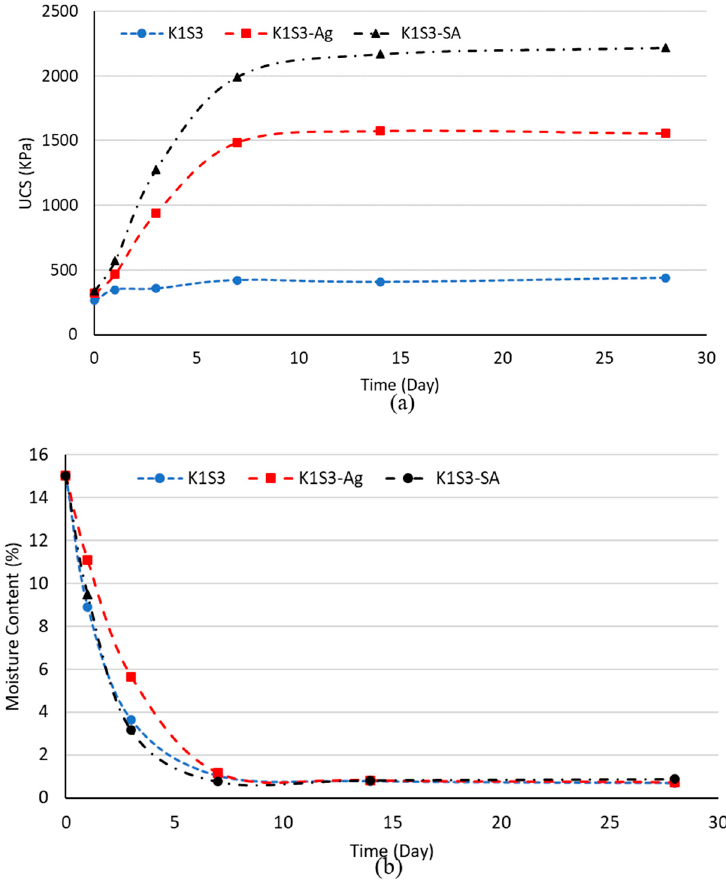
Figure 4. Biopolymer-treated K1S3 variation over time ( a ) UCS, ( b ) moisture level.